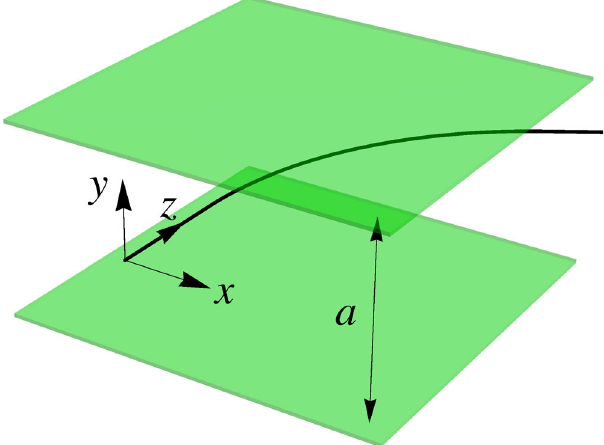
a and a plane orbit in 2